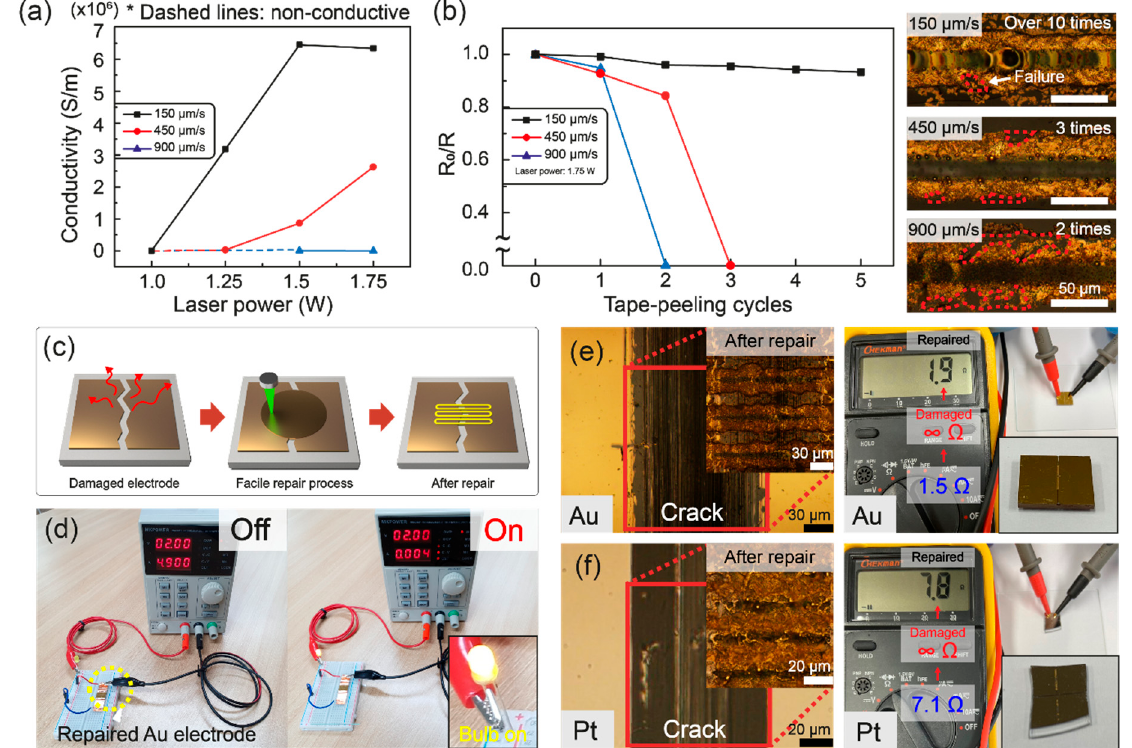
Figure 4. Characterizations of the fabricated Au electrodes by selective laser refining: ( a ) electrical conductivity of the Au electrodes according to the laser condition; ( b ) adhesive tape tests of Au electrodes according to the different scanning speeds of 150 μ m/s, 450 μ m/s, and 900 μ m/s at 1.75 W and measurements of relative resistances R 0 /R (R 0 : the initial resistance, R: the resistance after tape–peeling cycle) against repeated tape–peeling cycles (inset: optical images of Au electrode after iterative adhesive tape tests), and demonstrations and measurements of the facile repair method to damaged electrodes; ( c ) Schematic images of facile repair process using selective laser refining; ( d ) photographs of the circuit using a repaired Au electrode by the proposed method, optical images of both completely disconnected and then repaired ( e ) Au and ( f ) Pt electrodes, and the resistance measurements of the repaired electrode, respectively (original resistance of Pt: 7.1 Ω and Au: 1.5 Ω , repaired resistance of Pt: 7.8 Ω and Au: 1.9 Ω ).